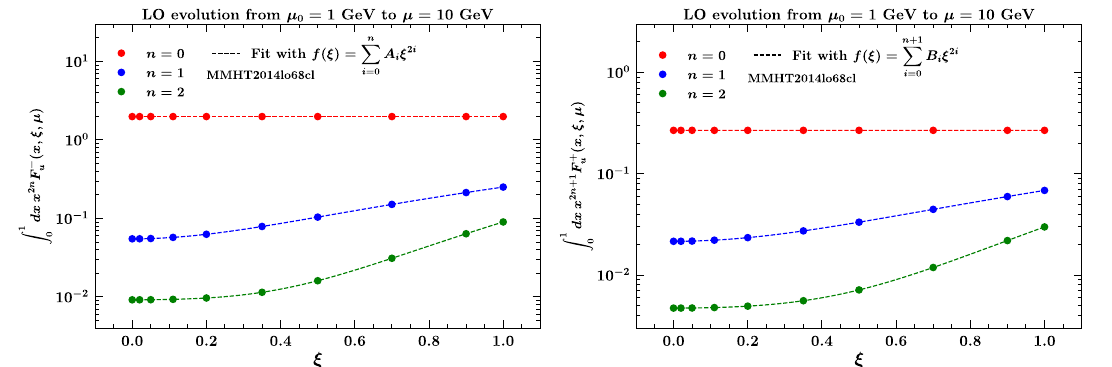
Fig. 5 Non-singlet (left) and singlet (right) up-quark Mellin moments for GPDs evolved from μ 0 = 1 GeV to μ = 10 GeV using the GPD evolution equations in Eq. (28) as functions of skewness ξ . Initial-scale